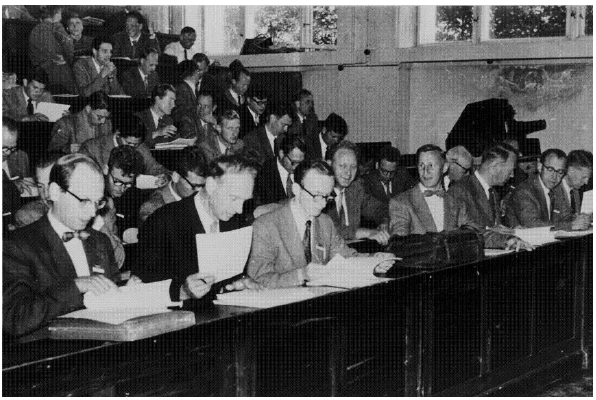
Figure 3: Participants at the summer course in